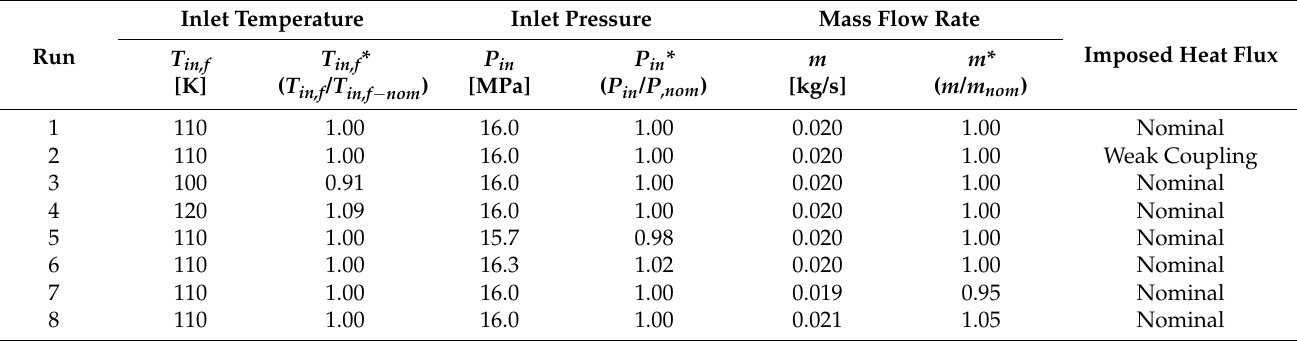
Table 3. Test matrix of the numerical